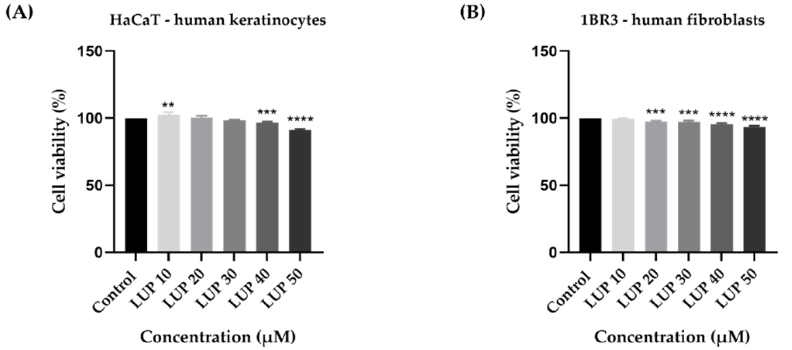
Figure 2. In vitro assessment of the effect LUP (10, 20, 30, 40 and 50 µM) exerts on the viability of ( A ) HaCaT and ( B ) 1BR3 healthy skin cells after 24 h of treatment by applying the MTT assay. The data are expressed as viability percentages (%) normalized to control cells and expressed as mean values ± SD of three independent experiments performed in triplicate. To identify the statistical differences between the control and the LUP-treated group, a one-way ANOVA analysis was conducted followed by the Dunett’s multiple comparisons post-test (** p < 0.01; *** p < 0.001; **** p < 0.0001).